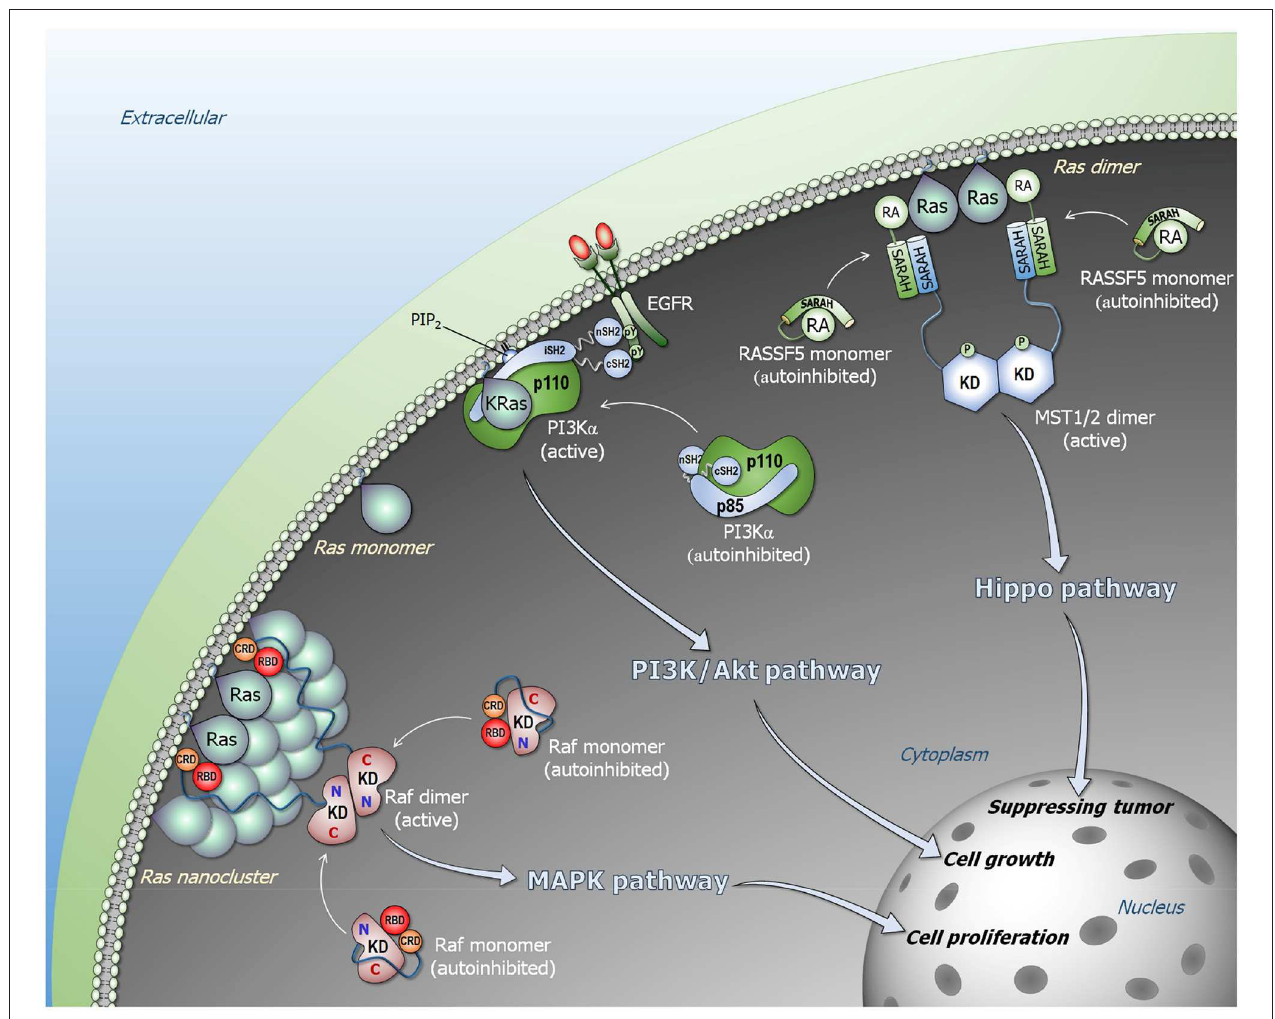
FIGURE 1 | Ras signaling pathways. Ras forms nanoclusters and promotes Raf dimerization in the Raf/MEK/ERK (MAPK) pathway (lower left). Monomeric Raf is autoinhibited in cytosol, and the high-affinity Ras–RBD interaction releases the autoinhibition, activating Raf through side-by-side dimerization. PI3K α is allosterically activated by EGFR (middle). The C-terminal phosphorylated tyrosine motif of EGFR liberates the SH2 domains of p85 α regulatory subunit from the p110 α catalytic subunit, releasing the autoinhibition of PI3K α . Ras binding is not link to the allosteric activation of PI3K α , but its binding contributes to further increase in the residence time of active PI3K α at the membrane. NORE1A (RASSF5) is an adaptor protein and autoinhibited by its RA domain interacting with its SARAH domain (upper right). In the presence of proximal Ras molecules, the Ras–RA interaction liberates NORE1A SARAH to recruit MST1/2 SARAH, promoting MST1/2 dimerization through